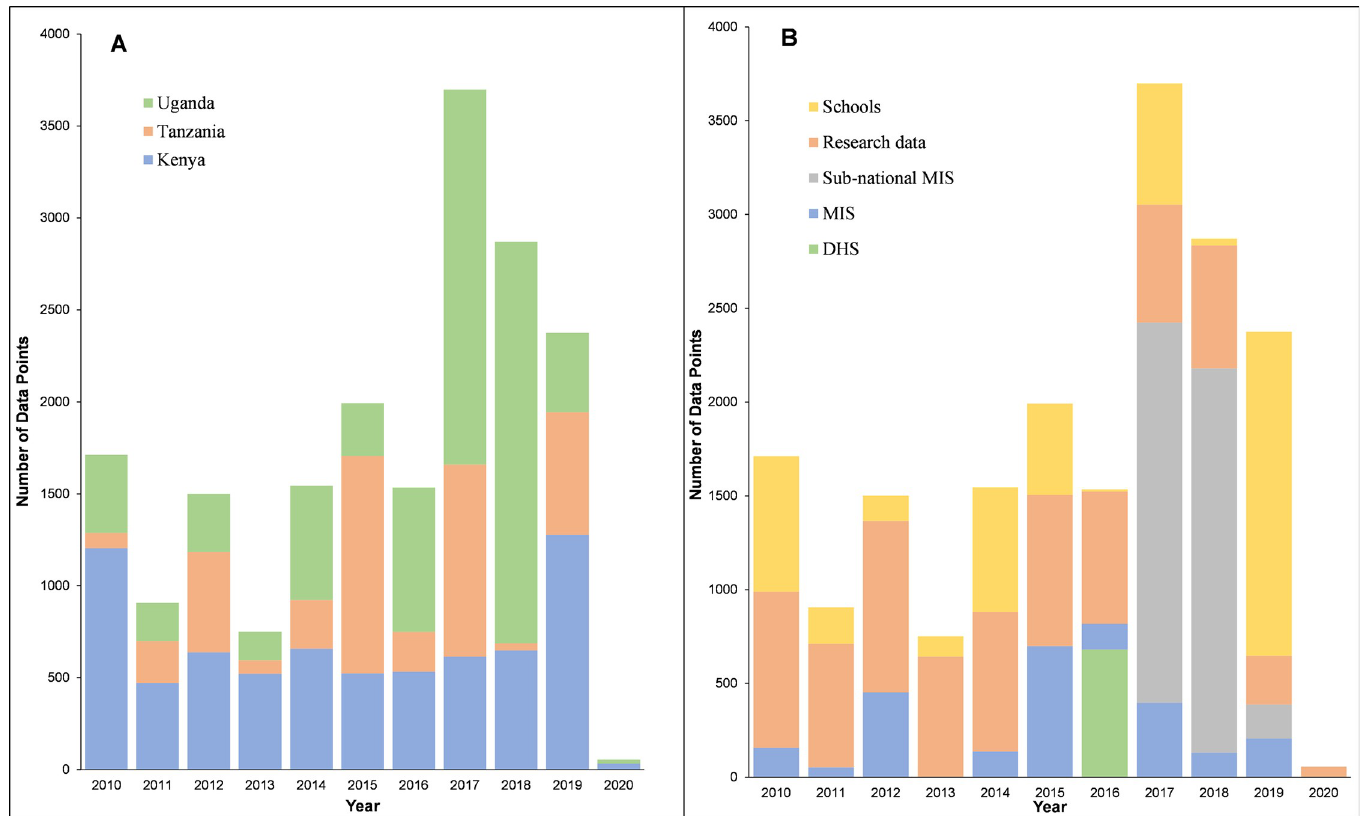
Fig 2. Assembled surveys by year and data source. (A) Temporal distribution of surveys 2010–2020 by country (B) Temporal distribution of surveys 2010–2020 according to the data source